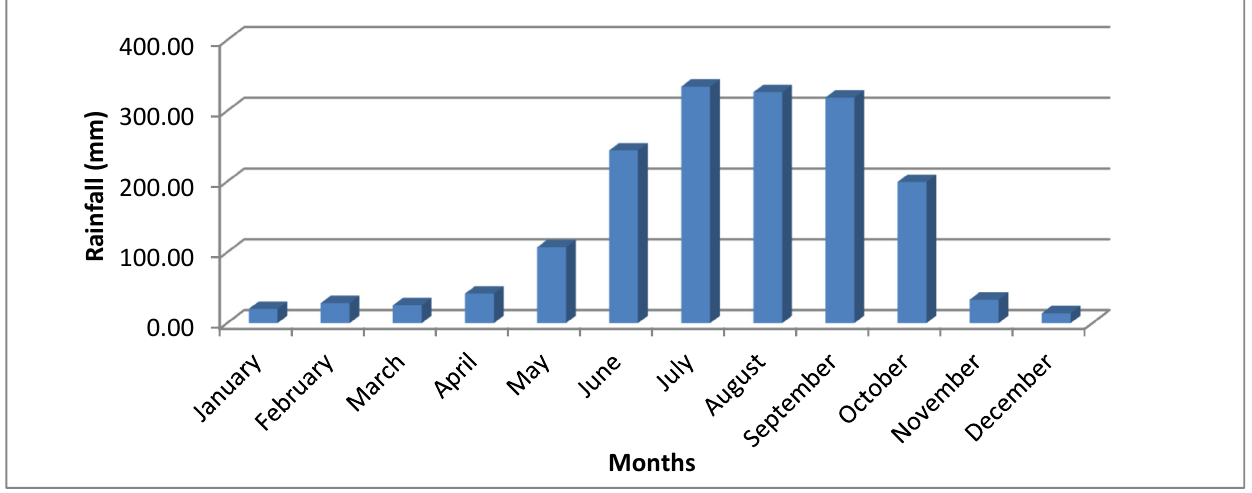
Figure 2. Average rainfall of the Purba Medinipur district (2002–2019).